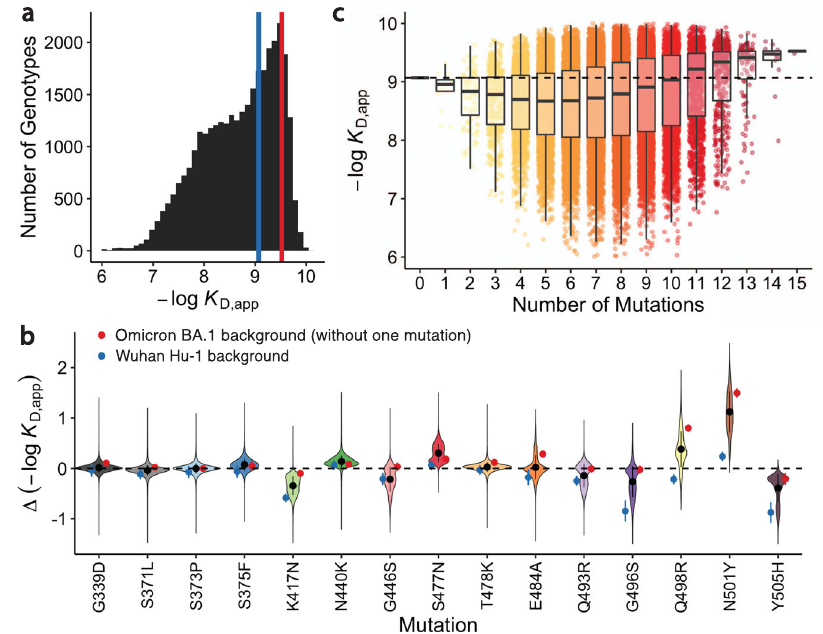
Fig. 1 | Binding af fi nity landscape. a Distribution of binding af fi nities to ACE2 across all N=32,768 RBD genotypes tested. Binding af fi nities are shown as - log K D,app ; vertical blue and red lines indicate the -log K D,app for Wuhan Hu-1 and Omicron BA.1, respectively. b Distributions of the effectof each mutationonACE2 af fi nity (de fi ned as the change in -log K D,app resulting from mutation) across all possiblegeneticbackgroundsattheother14loci.Blacklinesegmentsindicate25th and 75th percentiles of the effect distributions and points represent distribution